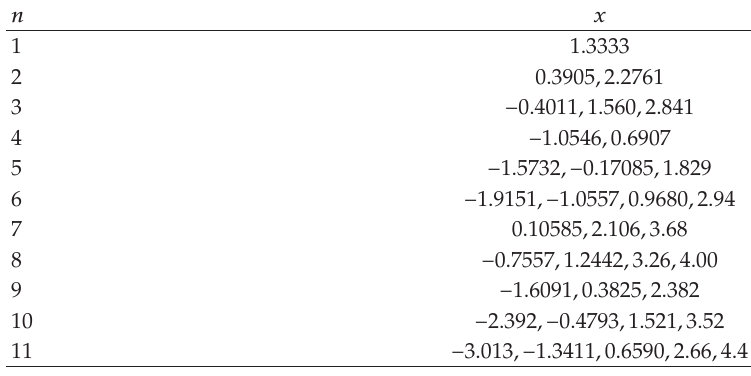
Table 2: Approximate solutions of E n,q,w (cid:2) x : a (cid:3) (cid:6) 0 ,x ∈ R .